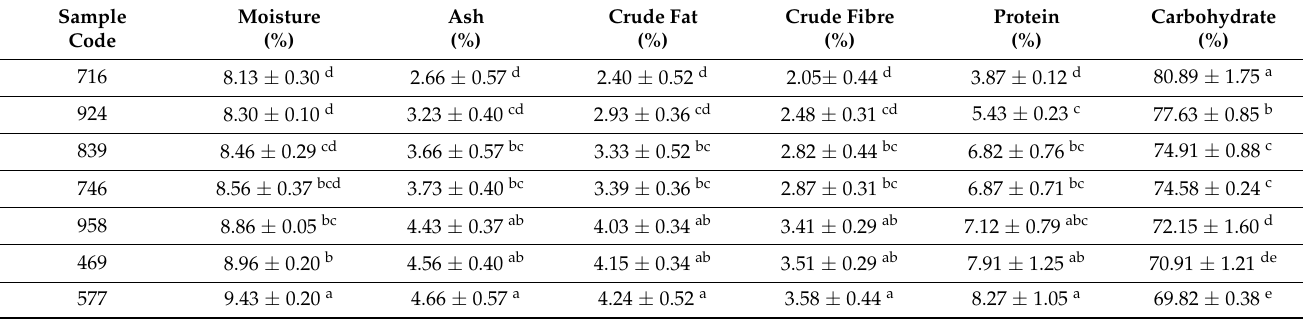
Table 4. Proximate composition of fermented millet “ Ibyer ” beverage enhanced with ginger powder. Sample